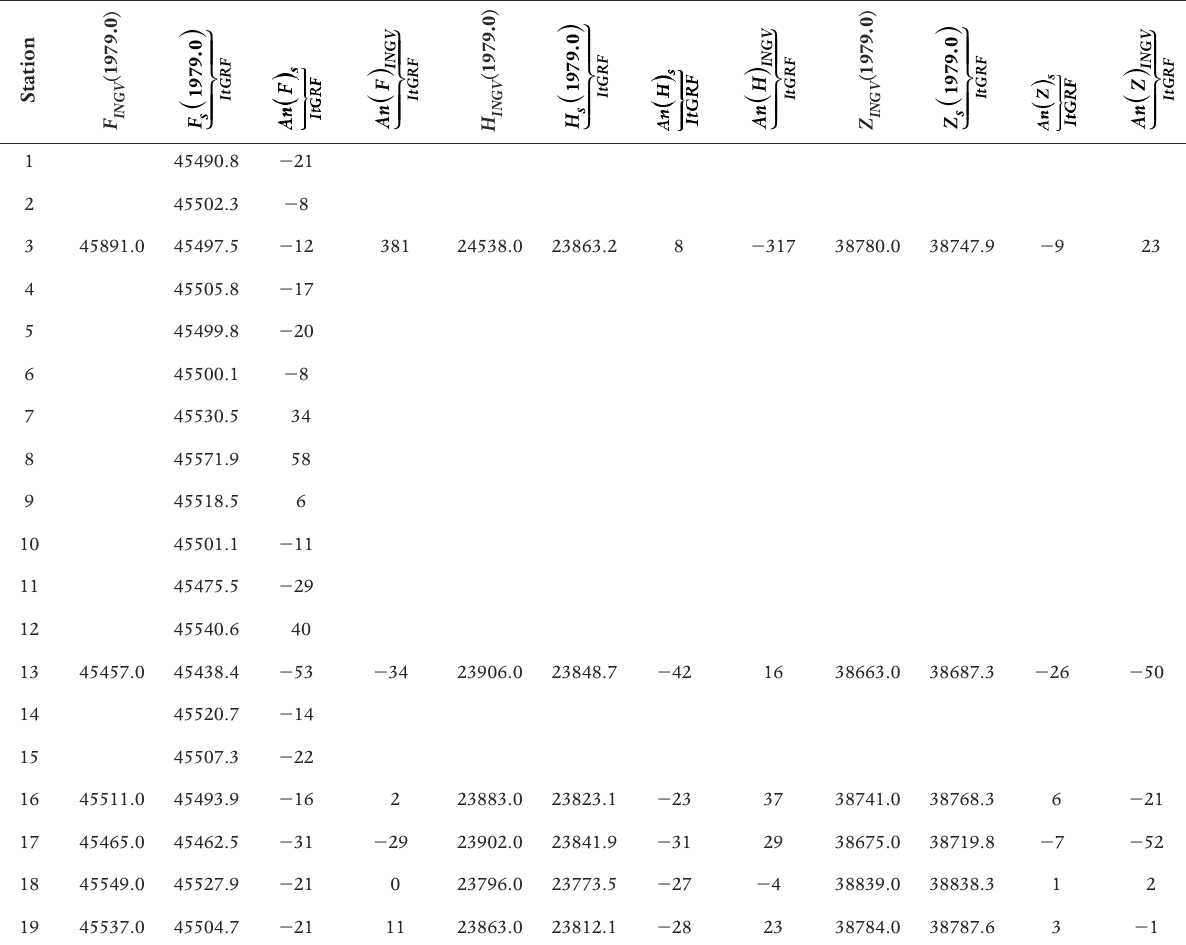
(1979.0) = values of element E at 1979.0 from Italian database; ° = values of element Table 3. Values of magnetic element at 1979.0: E INGV E on station s reduced at 1979.0 with the ItGRF; °° = values of anomaly of the element E on station s respect ItGRF; °°° = values of anom- aly of the element E on Italian database with respect to ItGRF.